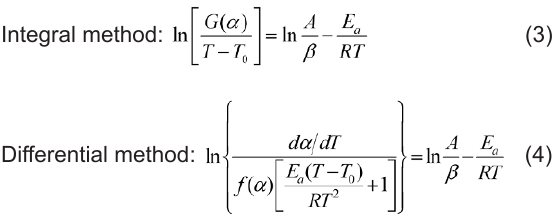
Figure 4. p-t and d p /d t-t curves of NH